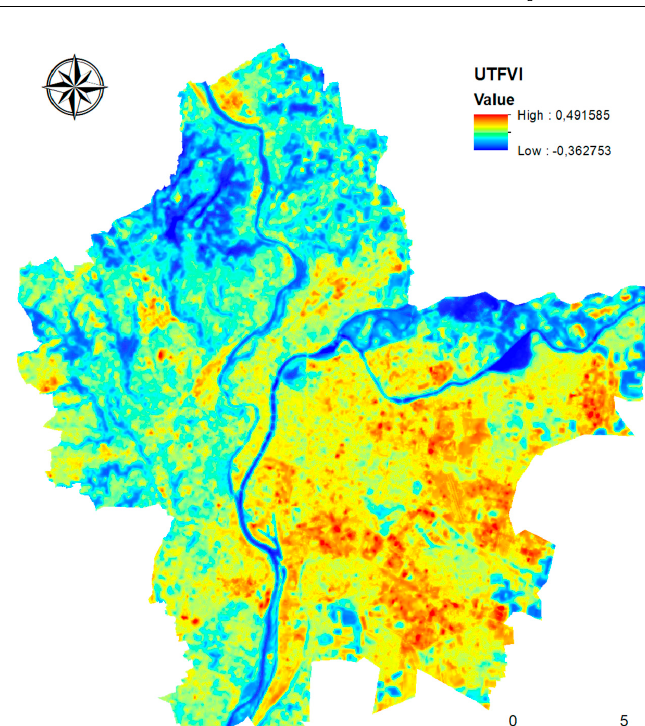
Figure 7. UTFVI on 16 July 2017 in Lyon urban area.